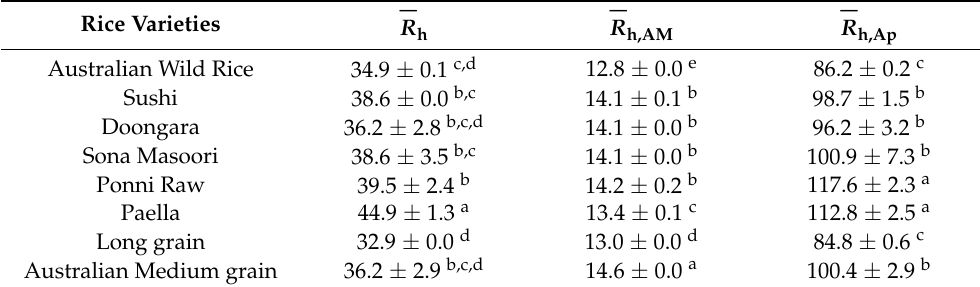
— R h,AM ), and — R h,Ap